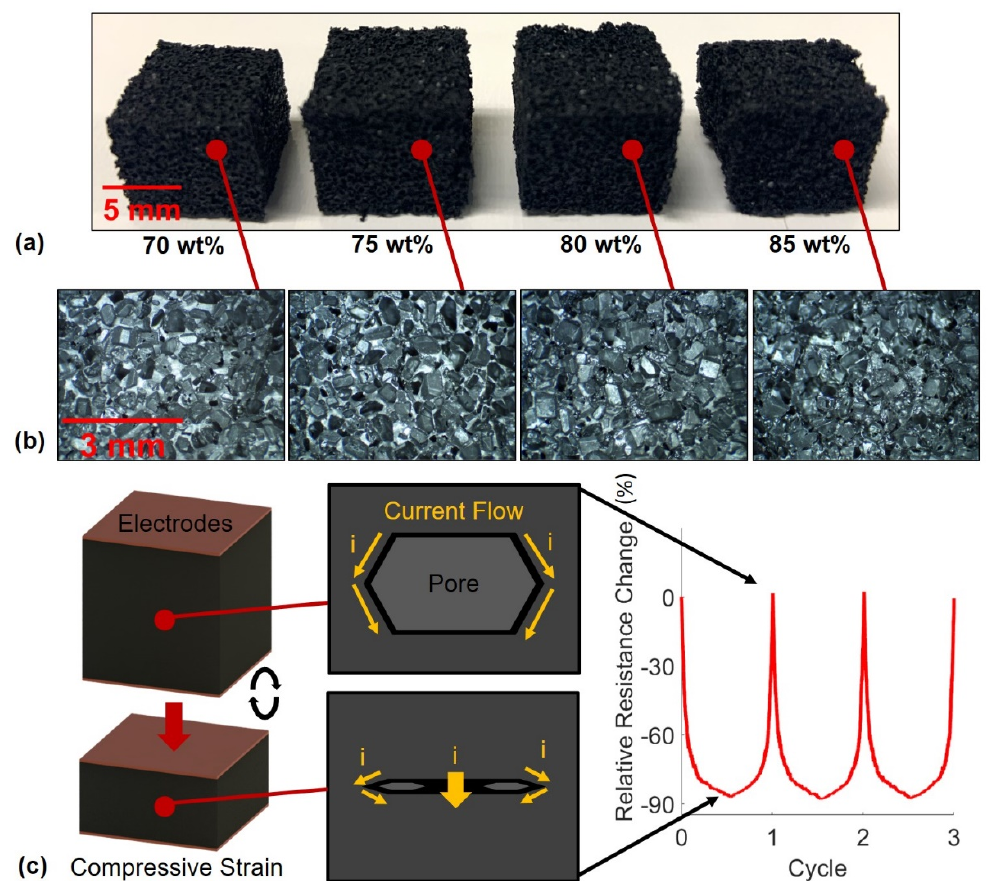
Figure 3. ( a ) Various porosity sponges with CNT loadings of 3 wt%, ( b ) microstructure of the varying porosity sponges, and ( c ) schematic illustrating the piezoresistive mechanism of a collapsed pore in the sponge sensors.